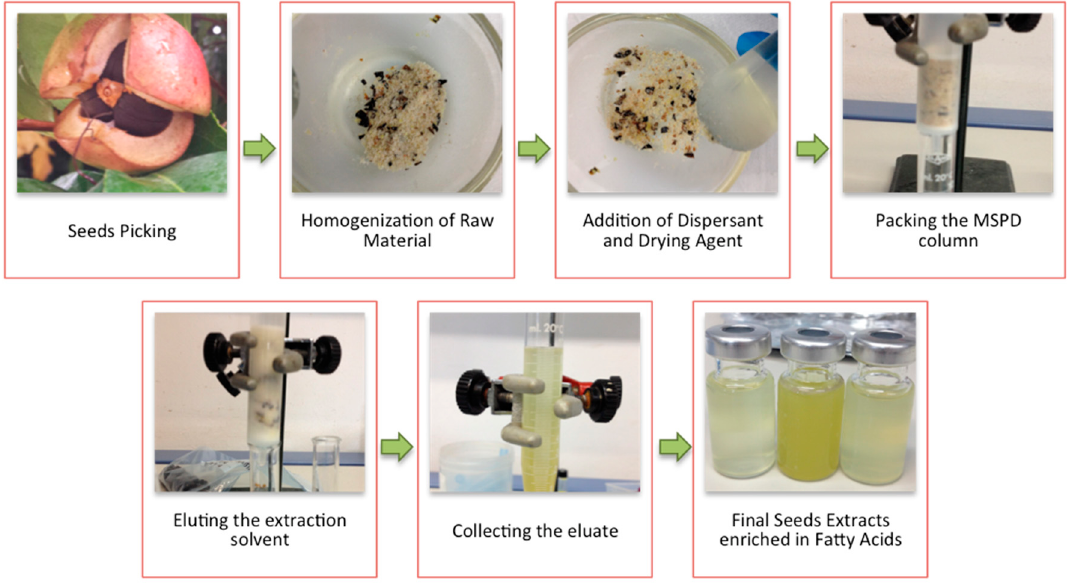
Figure 1. Scheme of the Matrix Solid Phase Dispersion Procedure for Camellia Seeds.